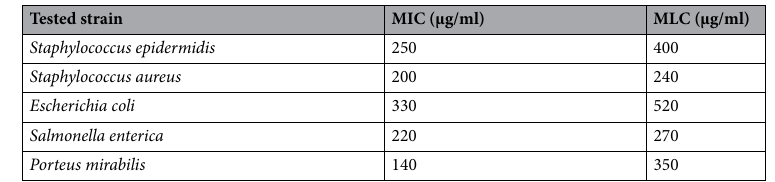
Table 6. Broth macro dilution method for determination of minimum inhibitory and minimum lethal concentration values of the biosynthesized silver nanoparticles .